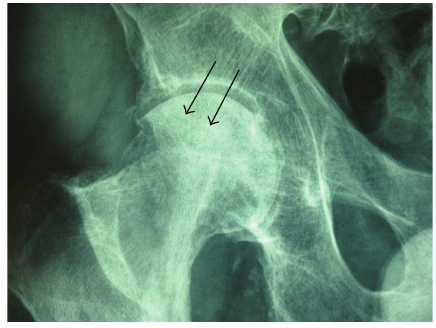
Figure 1: Radiographic aspect of hip fracture Garden 3 secondary to amyloidoma.